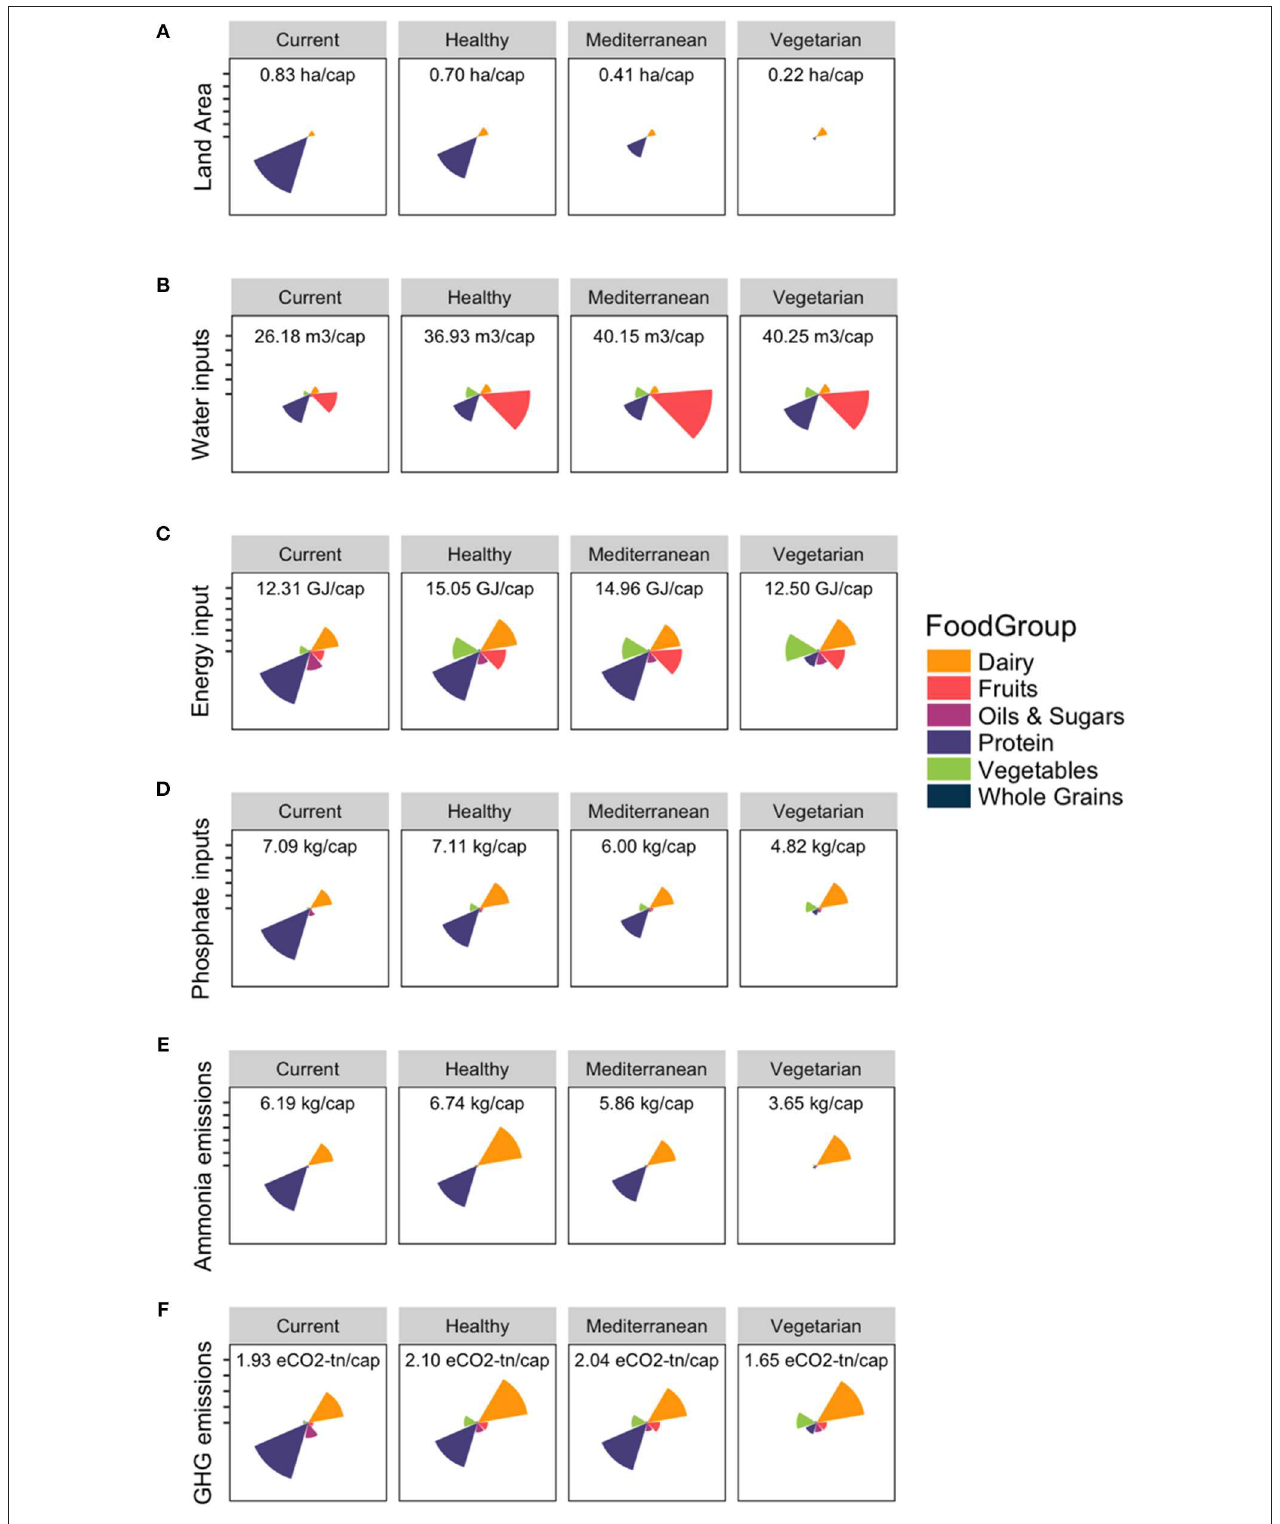
FIGURE 3 | Comparison of the relative environmental footprints for the six major diet food groups as measured by (A) land area, (B) blue water input requirements, (C) energy input requirements, (D) phosphate input requirements, (E) ammonia emissions and (F) greenhouse gas emissions (eCO 2 ) for the current diet and three recommended diet patterns from the 2015–2020 Dietary Guidelines for Americans at a common 2,600 kcal intake level. Petal size is scaled relative to the largest value within an environmental footprint category and the total per-capita size of each diet’s footprint is listed at the top of each panel.